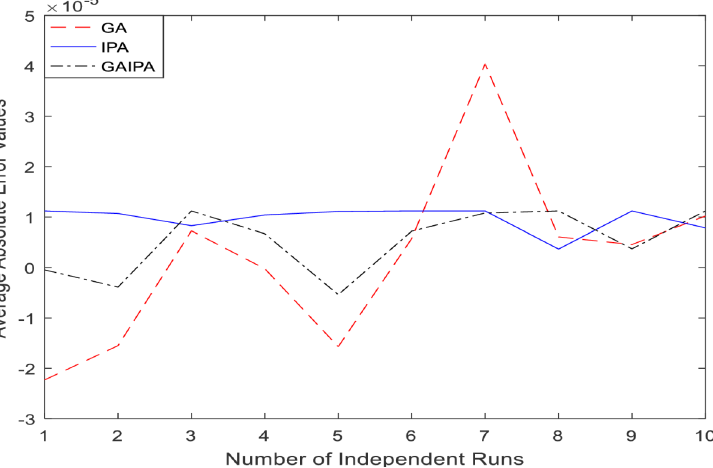
Fig 6. Graphical representation of average absolute errors for Example #01 when δ = 2.0 using